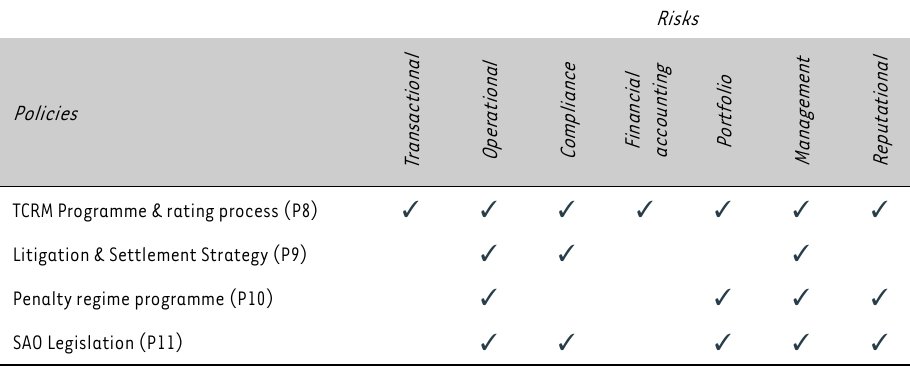
TABLE 2: TRM programmes in the UK